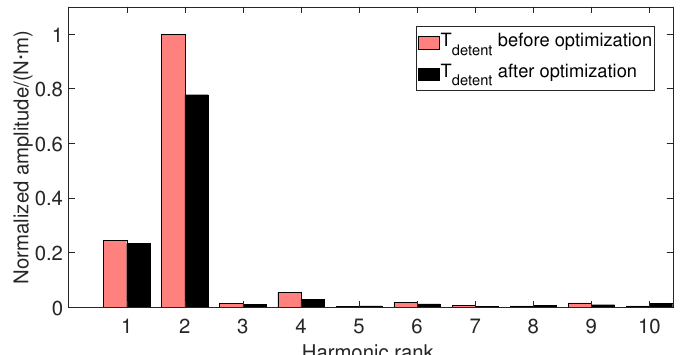
Figure 8. Comparison of detent torque harmonics before and after optimization.